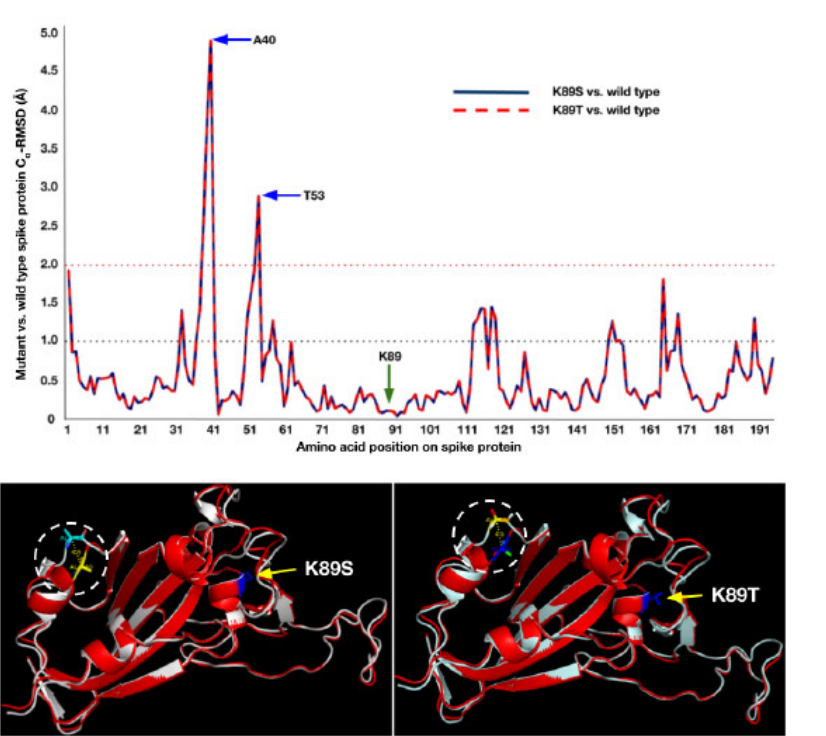
Figure 6. Structural deviation in the RBD of K89S/T mutants. The top panel shows RMSD of Cα atoms of mutants superposed onto wild type. Significant deviations were seen at positions 40 and 53. Bottom panels show the offsite structural deviations at position 40 on the respective mutant RBDs highlighted by white dashed circles.